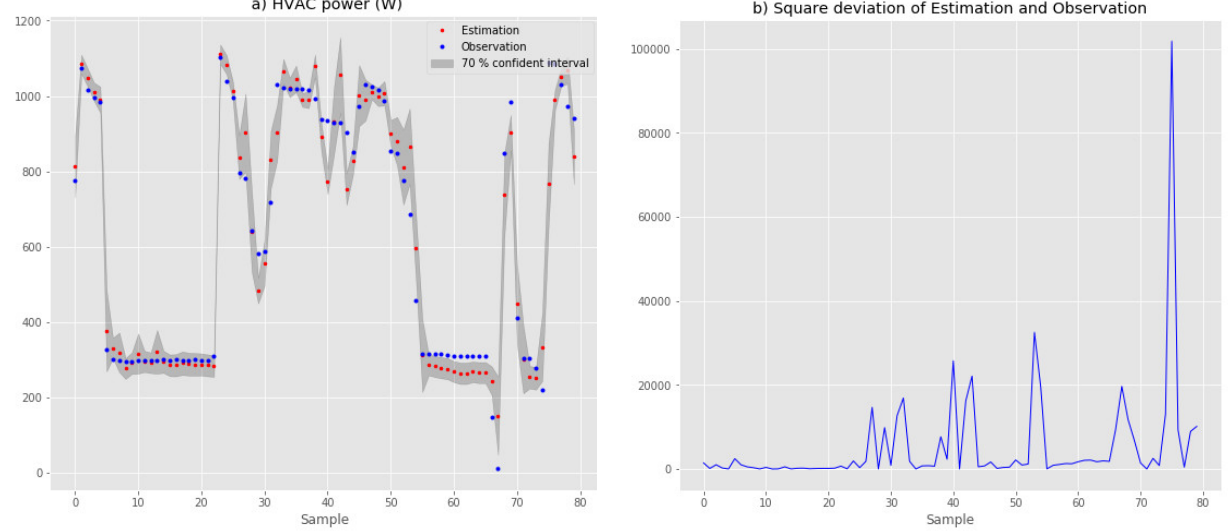
Figure 8. ( a ) Estimation and observation of HVAC power; ( b ) square deviation of the estimation and observation of HVAC power.